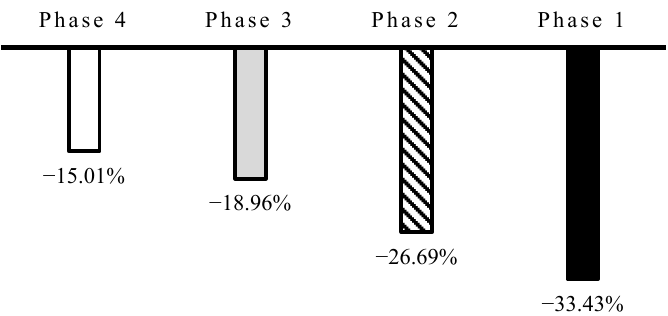
Figure 4. Average Maximum Drawdown by Portfolios over Sample Period.